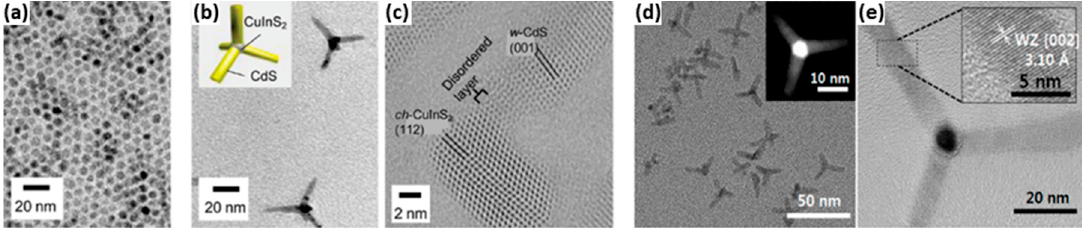
Figure 13. TEM images of CIS/ZnS TP heterostructures prepared with ( a – c ) CH CIS seeds. Reproduced with permission from [170]. Copyright RSC, 2016 ( d – e ) ZB CIS seeds. Reproduced with permission from [171]. Copyright American Chemical Society, 2018.